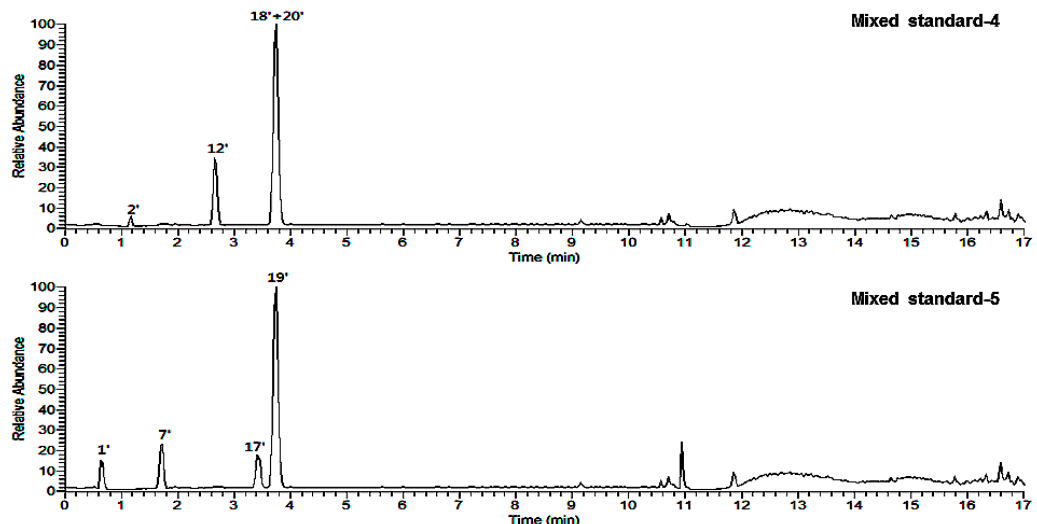
Figure 7. Base peak chromatograms of AM (the extract obtained from fresh the aerial parts of A. mongolicum heated reflux with 95% EtOH and 50% EtOH one time each, successively), AMH (H 2 O layer extract), AME (EtOAc layer extract), and mixed standard references.